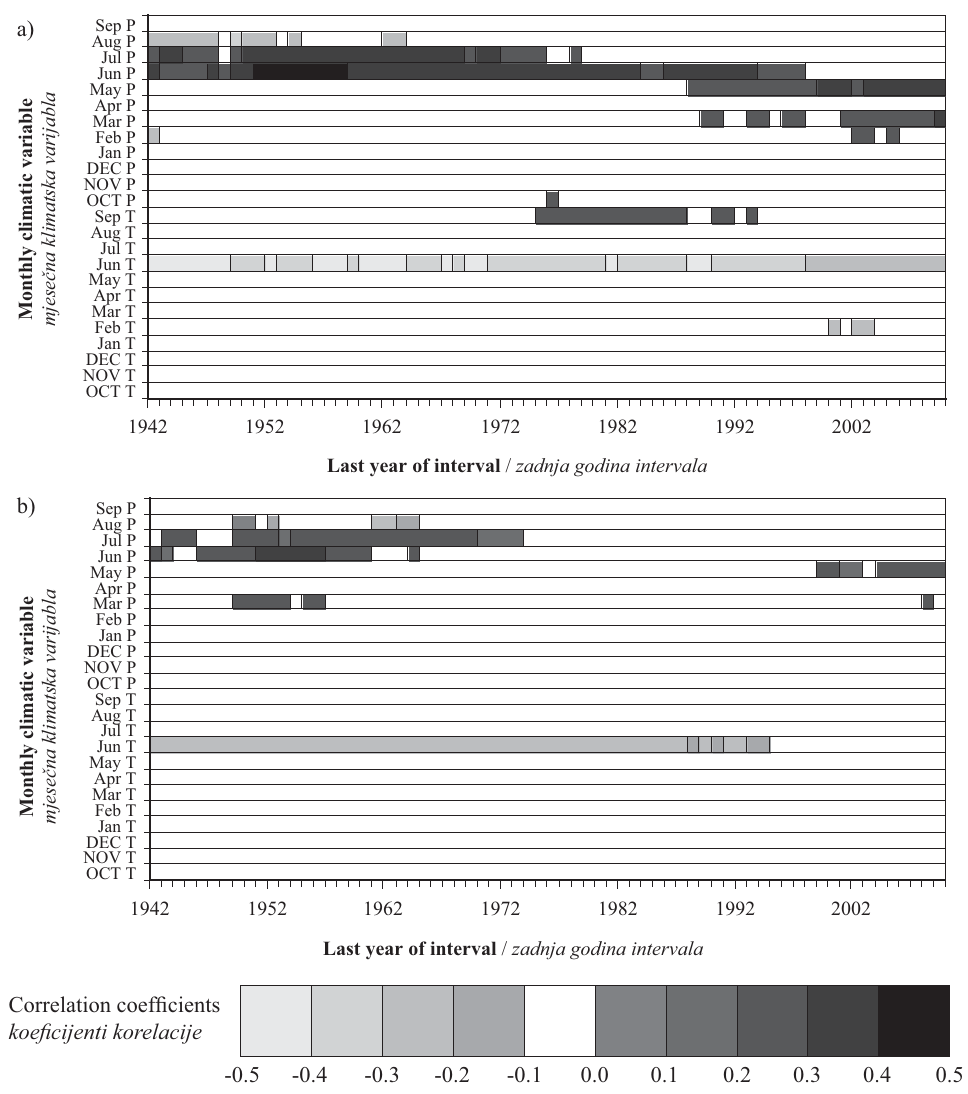
Figure 4 M oving correlation values (a) and response values (b), computed with DendroCLIM2002 (interval of 60 years); the fi rst interval is from 1922 to 1981 and the last from 1950 to 2009; months written in capitals mean months of the previous year ( i.e. DEC). Only signifi cant values are shown.